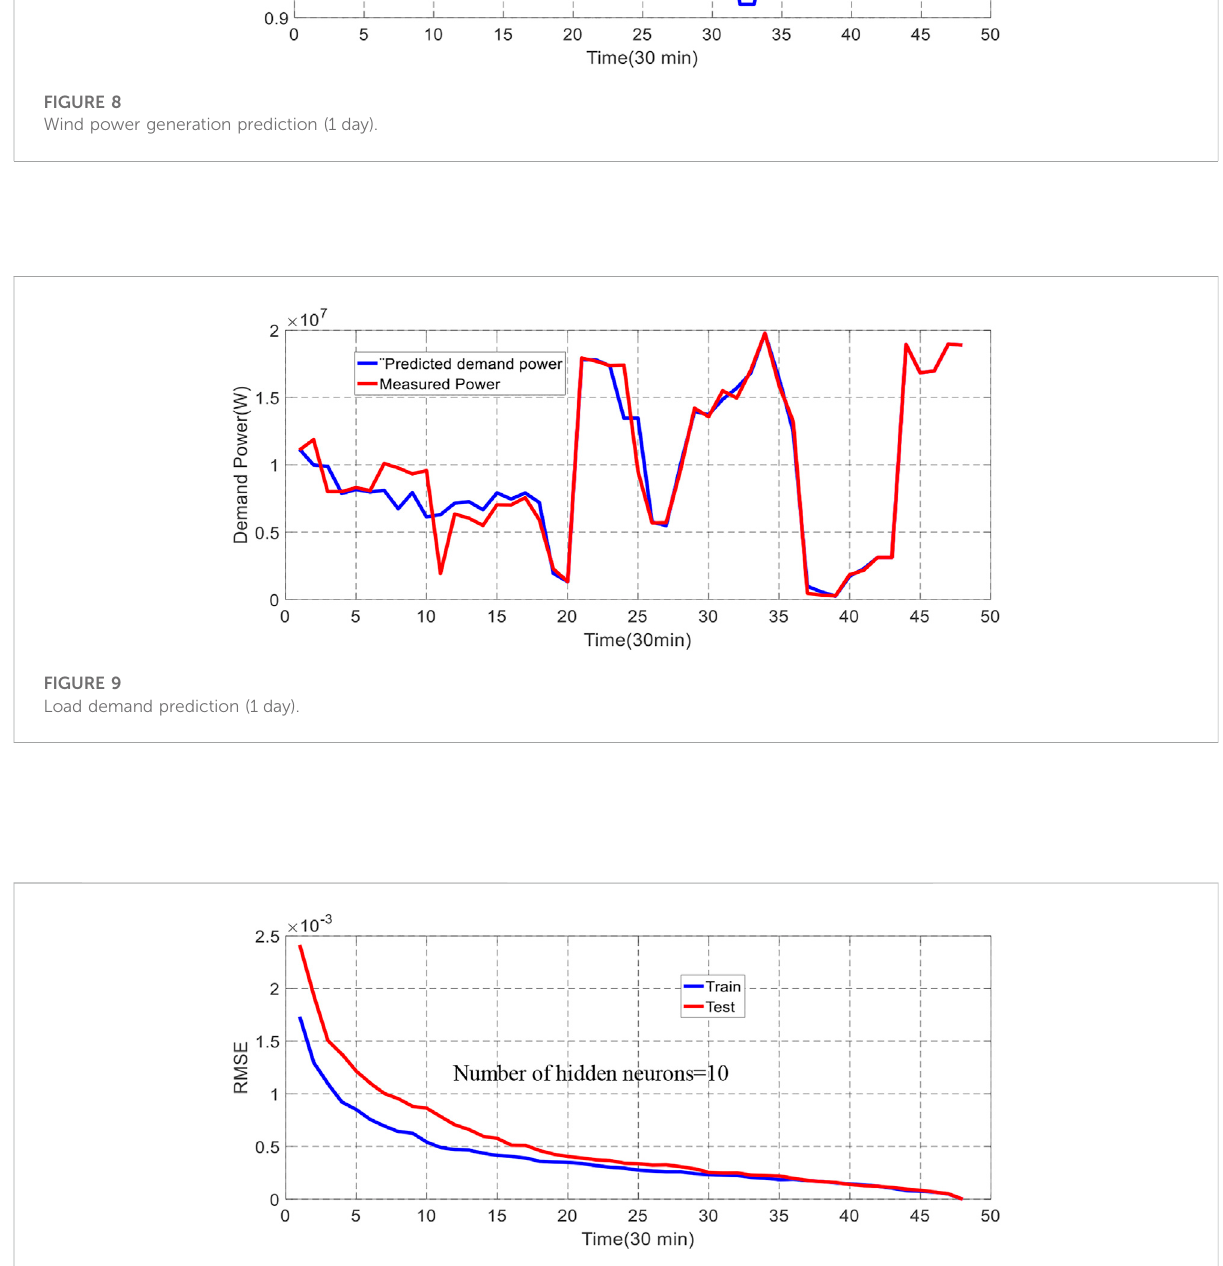
FIGURE 10 RMSE for wind power forecasting using 10 hidden neurons (1